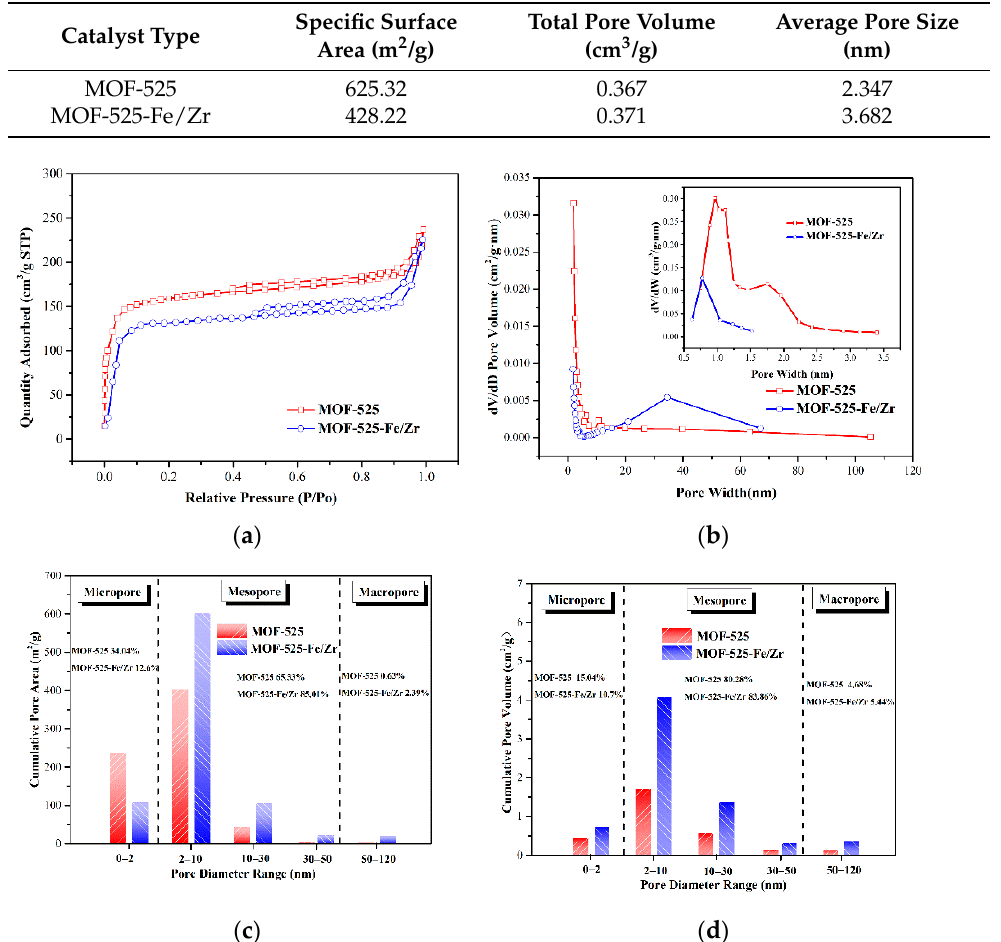
Table 2. Specific surface area and pore structure parameters of MOF-525 and MOF-525-Fe/Zr.